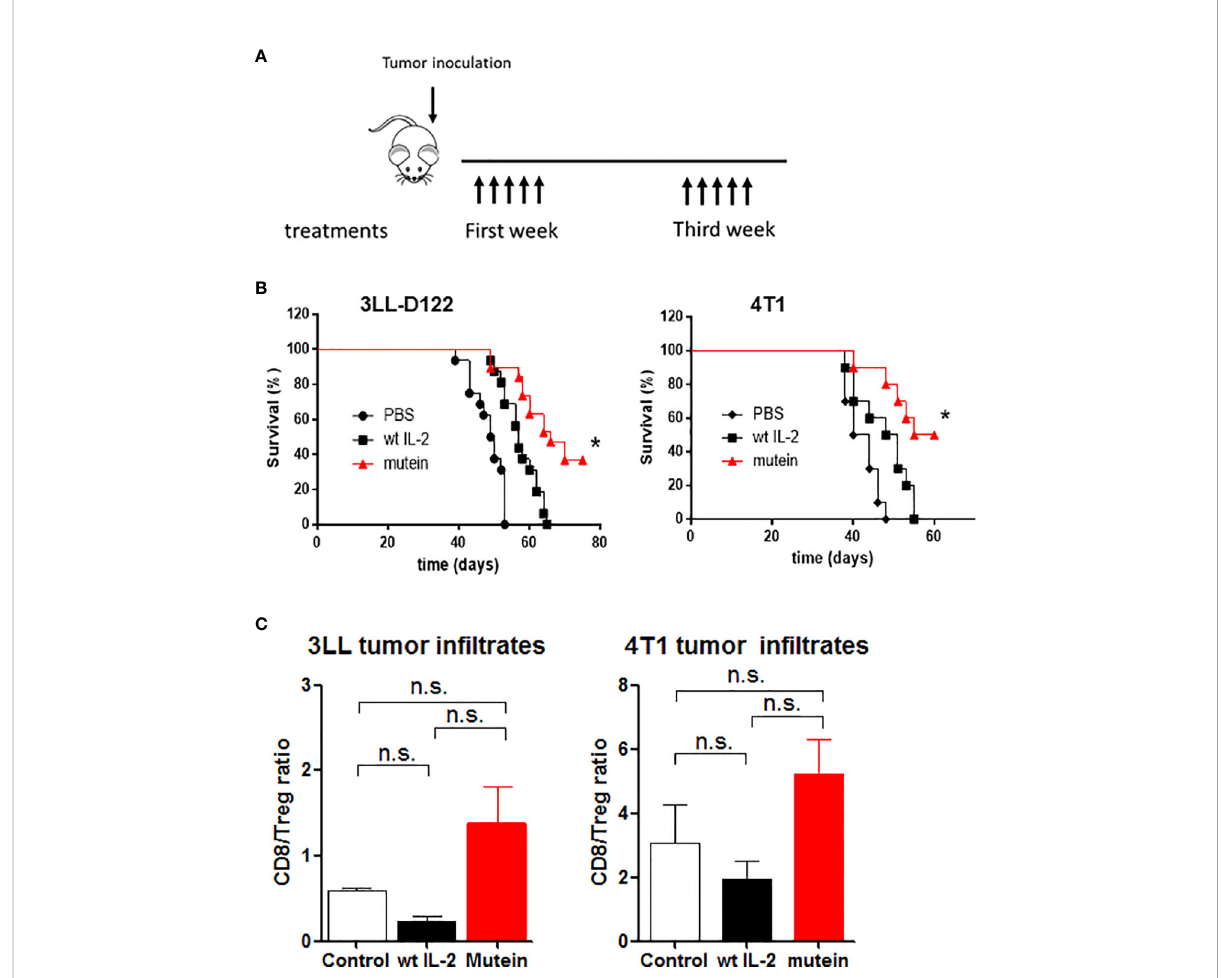
FIGURE 3 No-alpha mutein induces higher survival than wtIL-2 and induces changes in the tumor microenvironment. Mice were inoculated with 4T1 cells in the mammary gland or with 3LL-D122 on the foot pad; in the case of 3LL-D122, the primary tumors were eliminated by surgery when the control reached 9 mm; mice were treated with 30,000 IU wtIL-2 and 300 IU of no-alpha mutein or phosphate-buffered saline (PBS), and survival was observed. (A) Treatment schedule. (B) 3LL-D122 and 4T1 survival curves from spontaneous metastasis development. Survival curves were compared by log-rank test. (C) For tumor in fi ltrate measurement, mice were sacri fi ced when tumors reached 5 – 6 mm diameter and analyzed by fl ow cytometry. The graph represents the ratio between percentages of CD8 + T lymphocytes and Treg referred to as total CD45 + cells. n.s., non signi fi cant. *p<